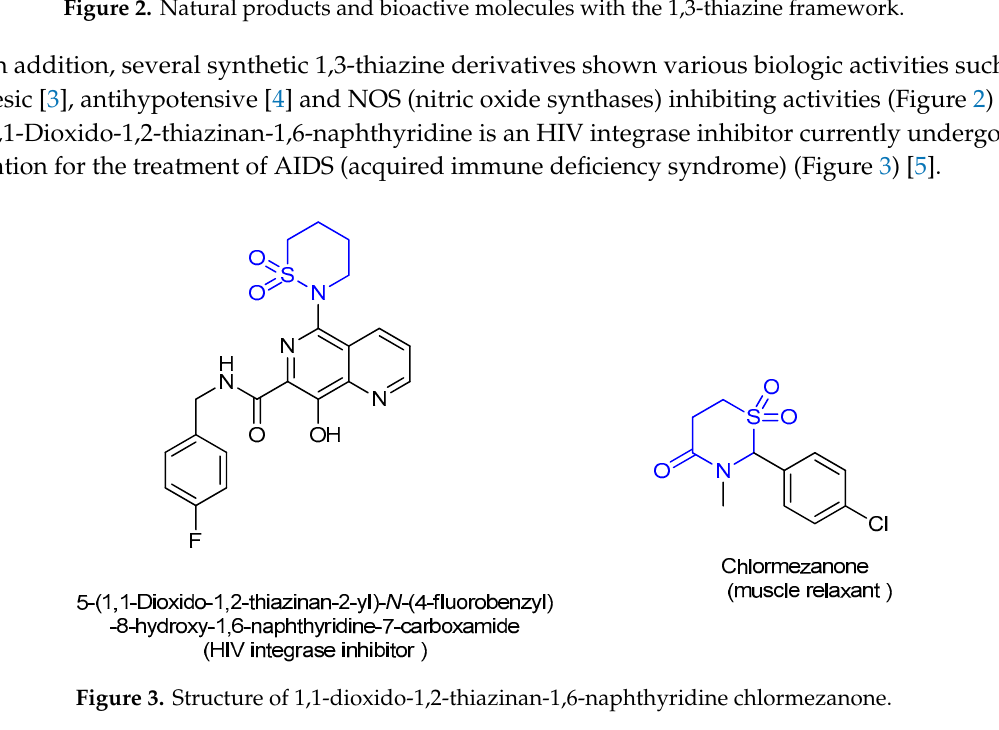
Figure 2. Natural products and bioactive molecules with the 1,3-thiazine framework.